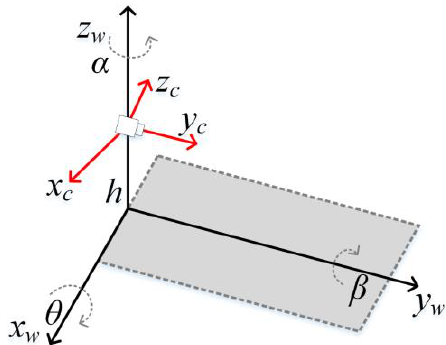
Figure 7. Three-dimensional (3D) world and camera coordinate systems, where θ , α , and β are inclination, yaw and roll angle of the vehicle, respectively.